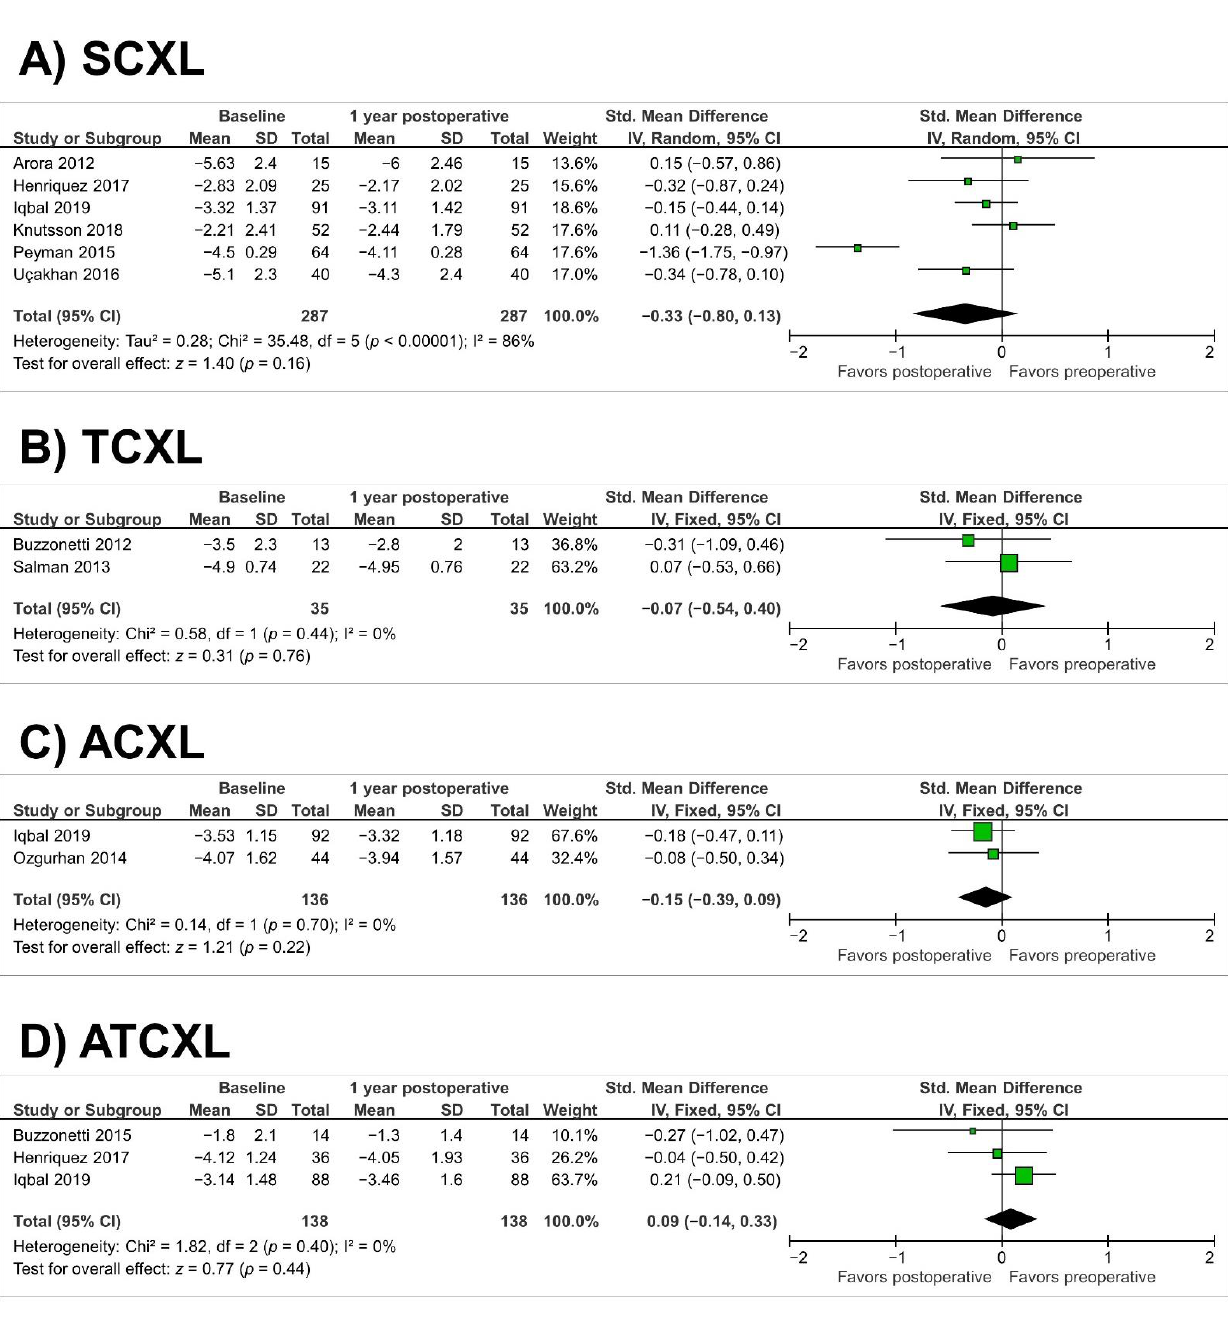
Figure 7. Forest plot of cylindrical refraction 1-year standardized mean differences in dioptres in studies included in meta-analysis. ( A ), standard cross-linking (SCXL); ( B ), accelerated CXL (ACXL); ( C ), transepithelial CXL (TCXL), ( D ), accelerated and transepithelial CXL (ATCXL). IV = inverse variance, CI = confidence interval, Tau 2 = tau-square statistic, Chi 2 = chi-square statistic, df = degrees of freedom, I 2 = I-square heterogeneity statistic, z = Z-statistic.